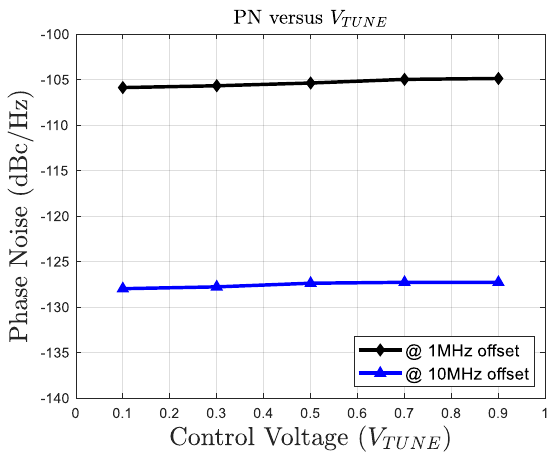
Figure 8. Simulated PN at 1- and 10-MHz offsets against control voltage ( 𝑉 𝑇𝑈𝑁𝐸 ).